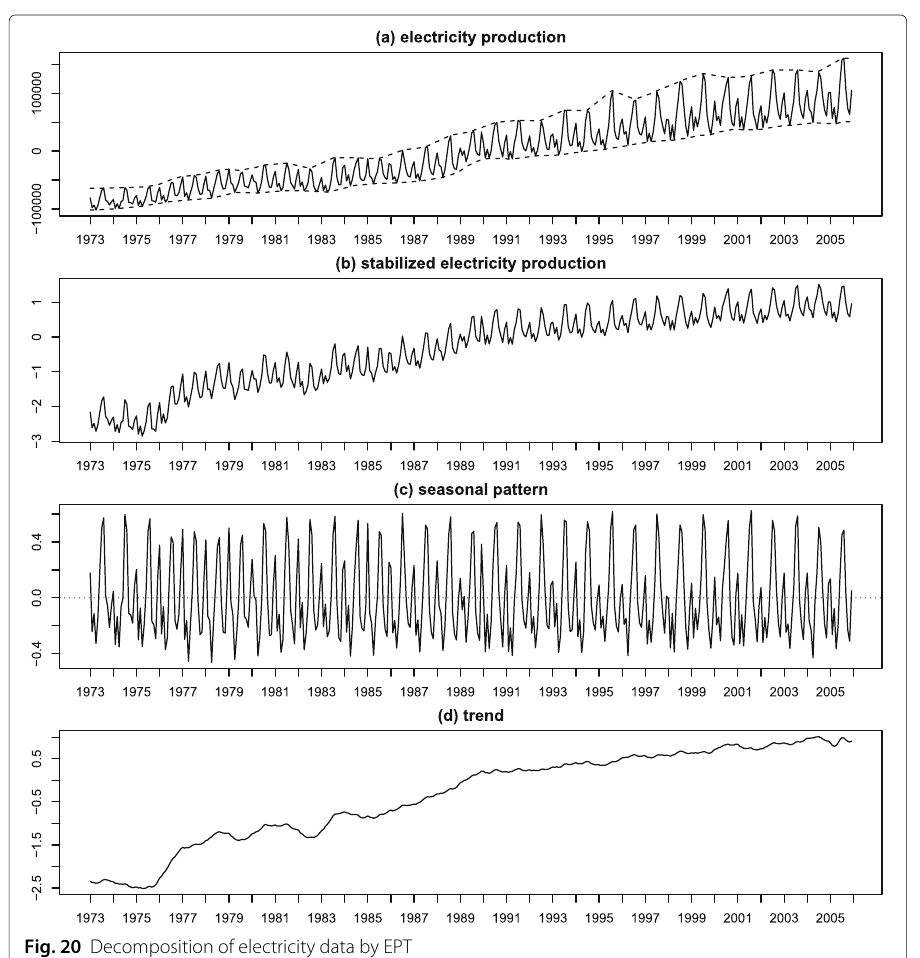
Fig. 20 Decomposition of electricity data by